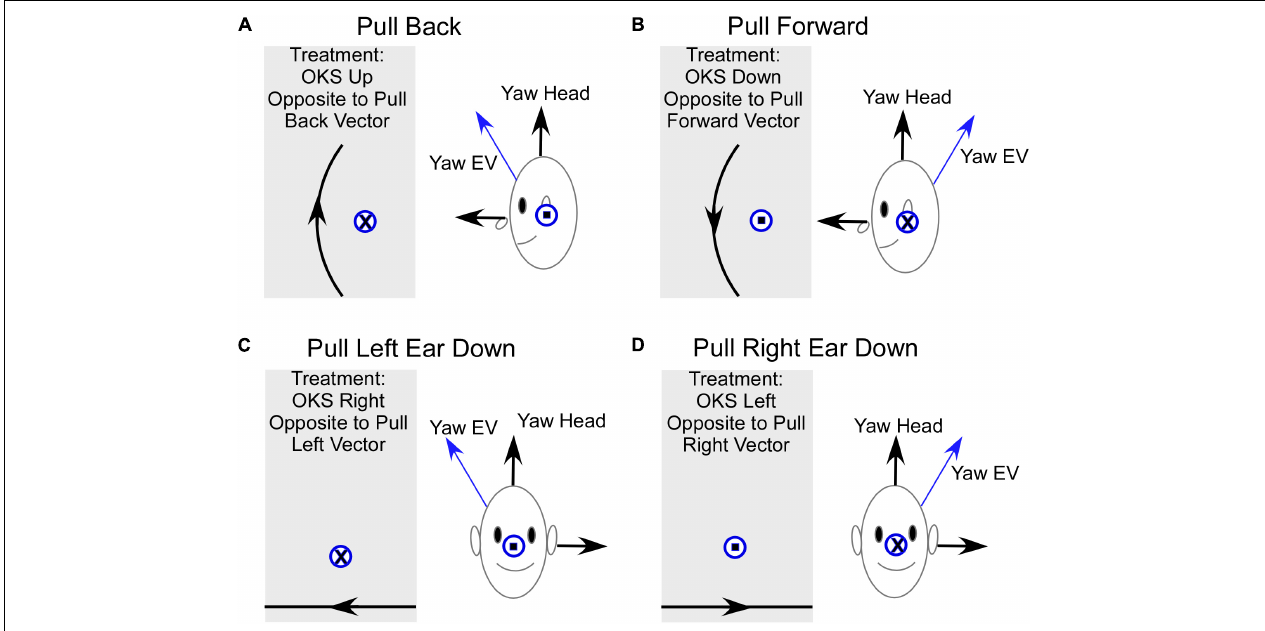
FIGURE 5 | Summary of the model-based predicted treatment protocol for gravitational pulling sensation. EV- Eigenvector. (A) Sideview of the pulling back sensation. The Yaw EV is shifted forward so the head yaw is back relative to the EV. The vector representing this pulling back sensation is the cross product of Yaw Head with Yaw EV and according to a right-hand rule, this is a vector out of the left ear (circle with a dot). The OKS treatment is OKS up, which re-adapts the Yaw EV toward Yaw Head. The direction of rotation of OKS represented by a circle with an x, opposite to the maladapted vector rotation. (B) Sideview of the pulling forward sensation. The Yaw EV is maladapted back re the Yaw Head, inducing a forward pulling sensation. The vector for this rotation is into the left ear (circle with an x) and the OKS stimulus to readapt is down and represented by a vector out of the left ear. (C) Pull Left ear down. This occurs when the Yaw EV is rotated right. The appropriate treatment using horizontal OKS is toward the right, which because of the known cross-coupling of velocity storage would adapt the Yaw EV toward the Yaw Head. It should be noted that the model predicts that a more potent OKS stimulus to re-adapt this shift in the EV would be a counterclockwise roll OKS from the subject viewpoint, which would be a vector opposing the rotation of the Yaw EV relative to the Yaw Head. (D) Pull Right Ear down. This occurs when the Yaw EV is rotated left relative to the Yaw Head. The appropriate treatment using horizontal OKS is toward the left, which because of the known cross-coupling of velocity storage would adapt the Yaw EV toward the Yaw Head. In this instance, the model predicts that a more potent OKS stimulus to re-adapt this shift in the EV would be a clockwise roll OKS from the subject viewpoint, which would be a vector opposing the rotation of the Yaw EV relative to the Yaw Head. Front view. Gray rectangles – screens with OKS stimulus. The direction of OKS is indicated by arrows. The direction of the OKS vectors for side down pulling sensation is consistent with previously studied cross-coupling when the head is tilted side